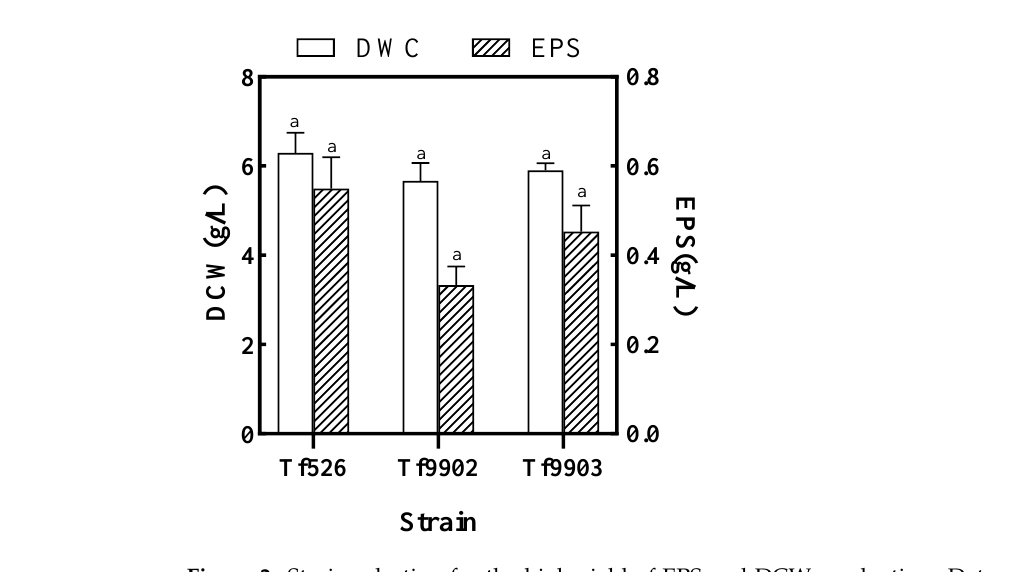
Figure 2. Strain selection for the high yield of EPS and DCW production. Data are expressed as mean ± SD, n = 3. Values with no letters in common are significantly different ( p < 0.05).